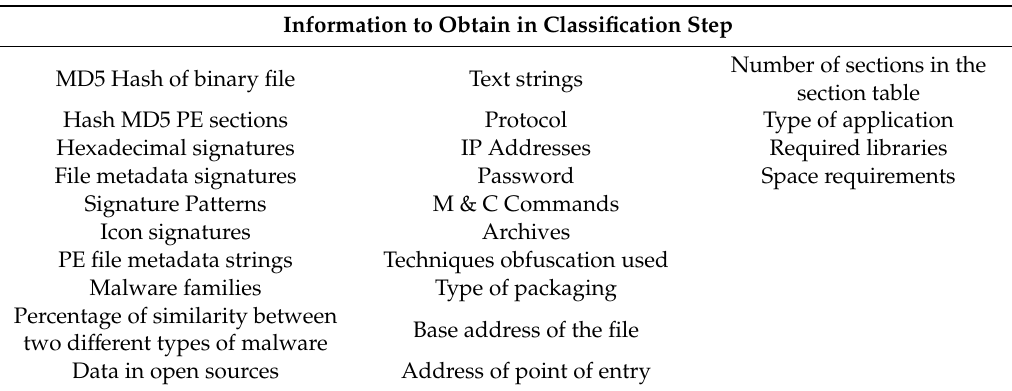
Table 3. Information to obtain in classification step.